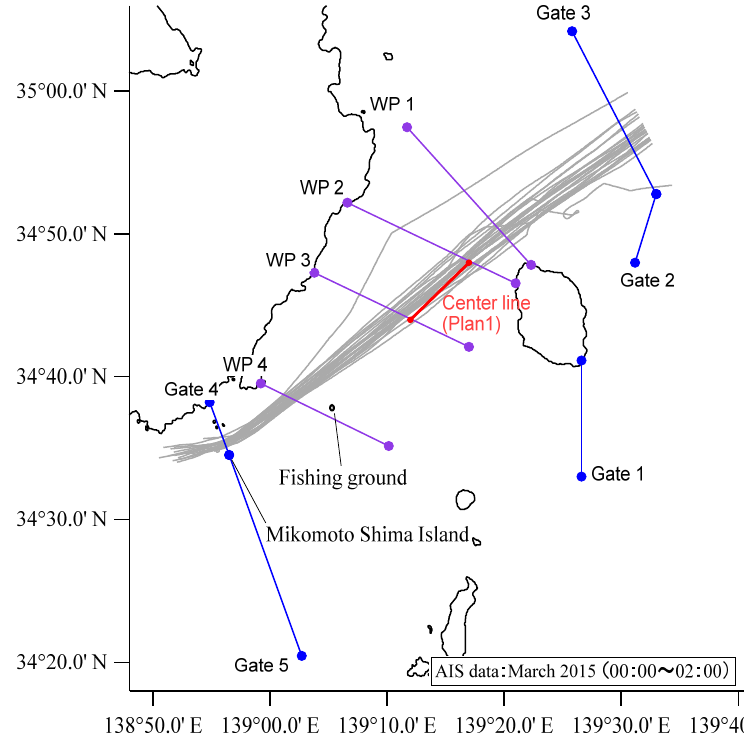
Figure 9. Gate and WP lines. Gray lines are the trajectories of category ID 0.